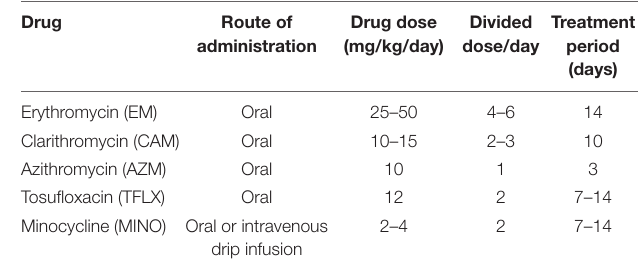
TABLE 5 | Recommended treatments for adult outpatients of macrolide-resistant M. pneumoniae pneumonia.